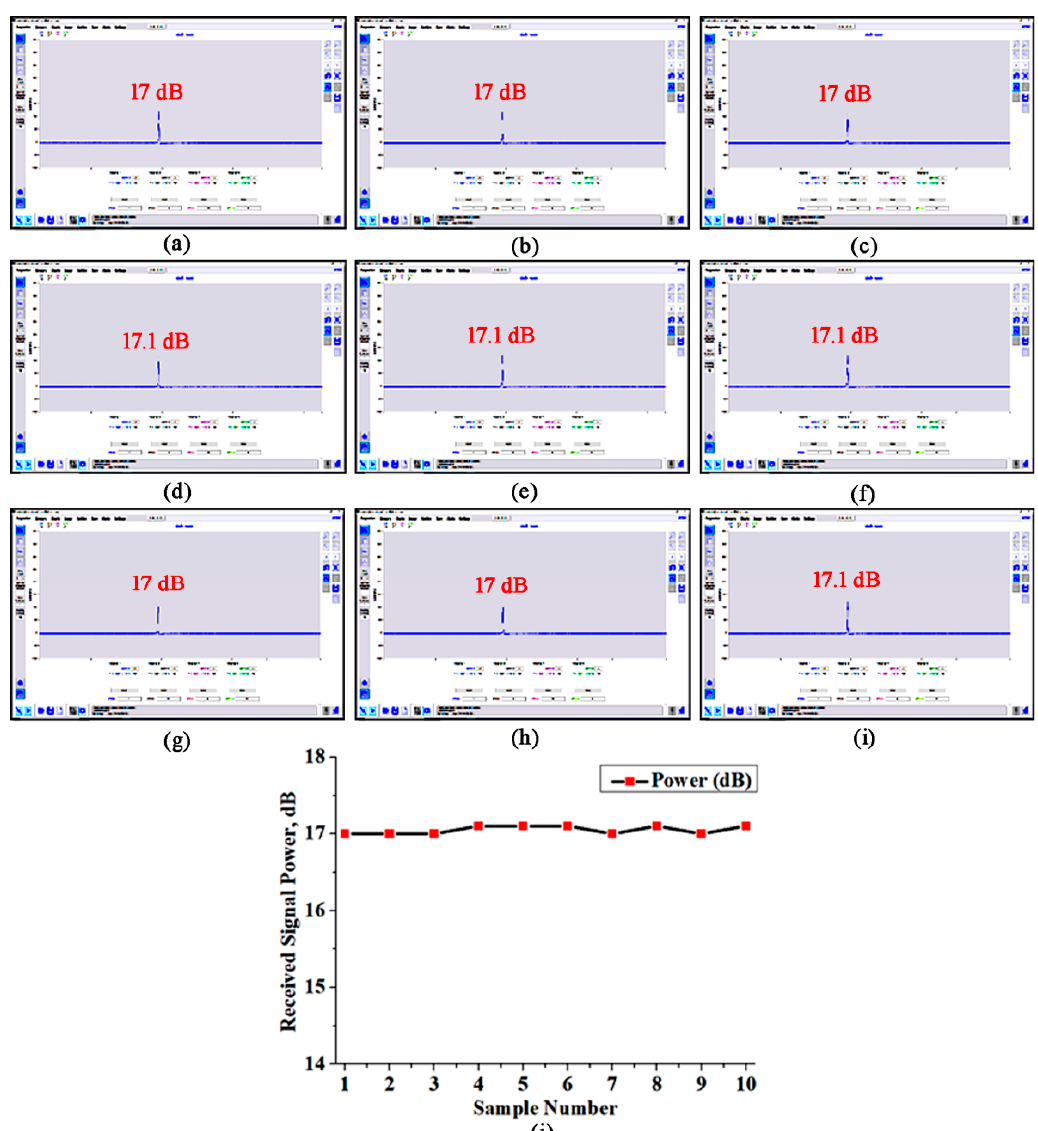
Figure 9. Received signal power from the FBG-inscribed F-doped optical fiber samples fabricated by IR femtosecond laser irradiated phase mask-assisted fabrication technology with a laser power of 350 mW, an exposure time of 15 s, and a FBG length of 5 mm. ( a – i ) Received signal power from nine optical fiber samples at the Bragg wavelength of 1542 nm; ( j ) plot of the received signal power for different optical fiber samples.